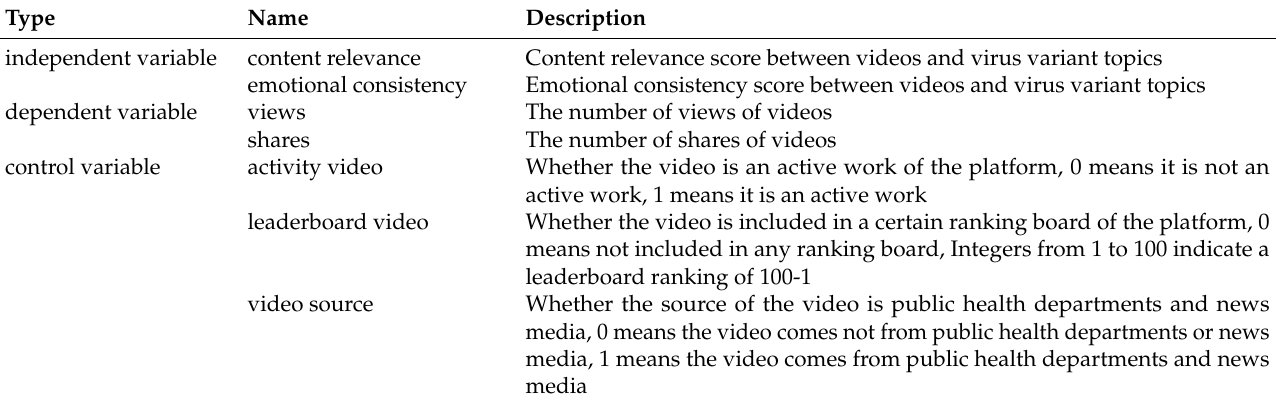
Table 1. Variables definition.